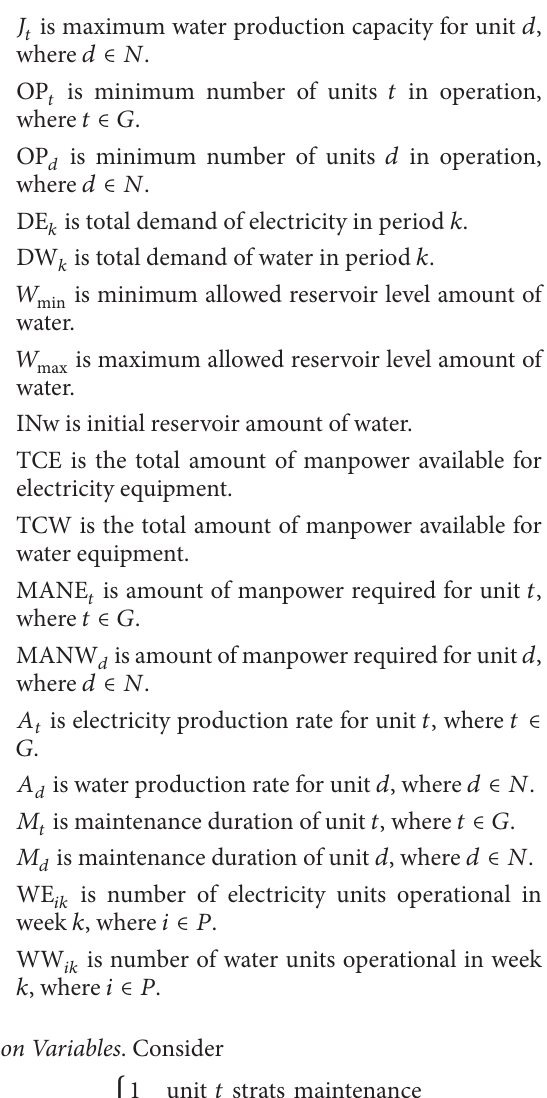
Figure 3: Schedule of 10 units to be maintained in time-horizon of 52 weeks.